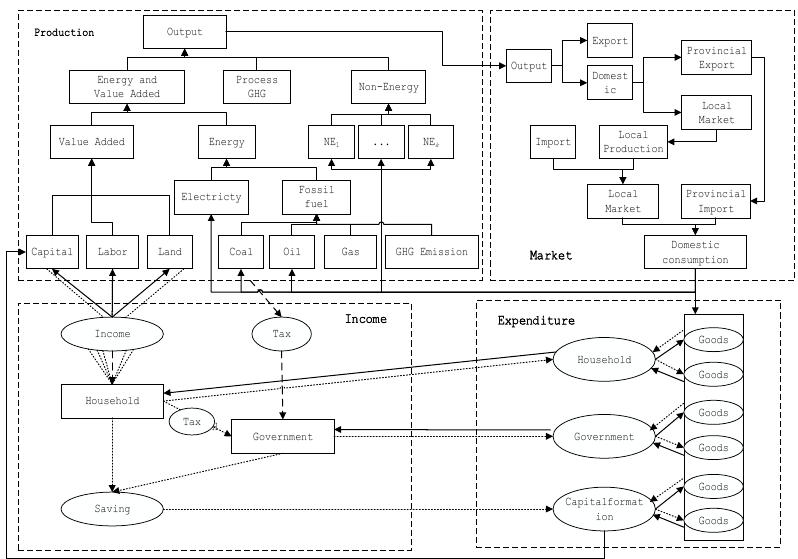
Figure A1. The framework of the two-region GD_CGE model for Guangdong Province and China (solid arrow: physical fl ow; dashed arrow: monetary fl ow).